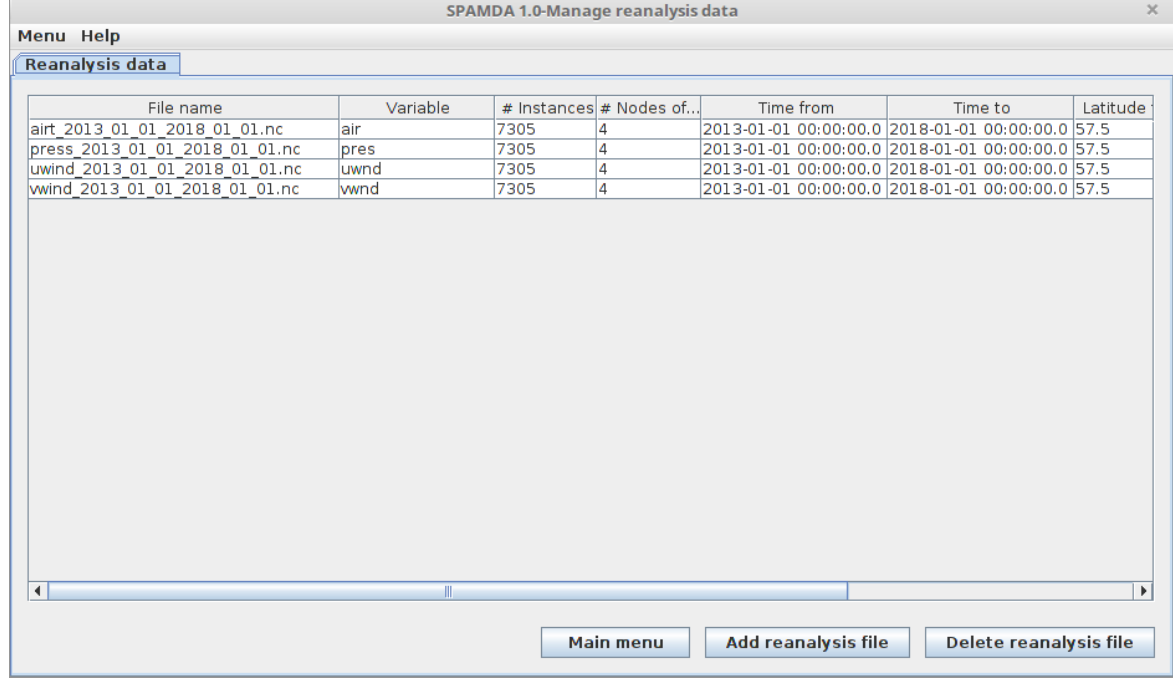
Figure 13. Manage reanalysis data view: downloaded files containing the four closest reanalysis nodes.